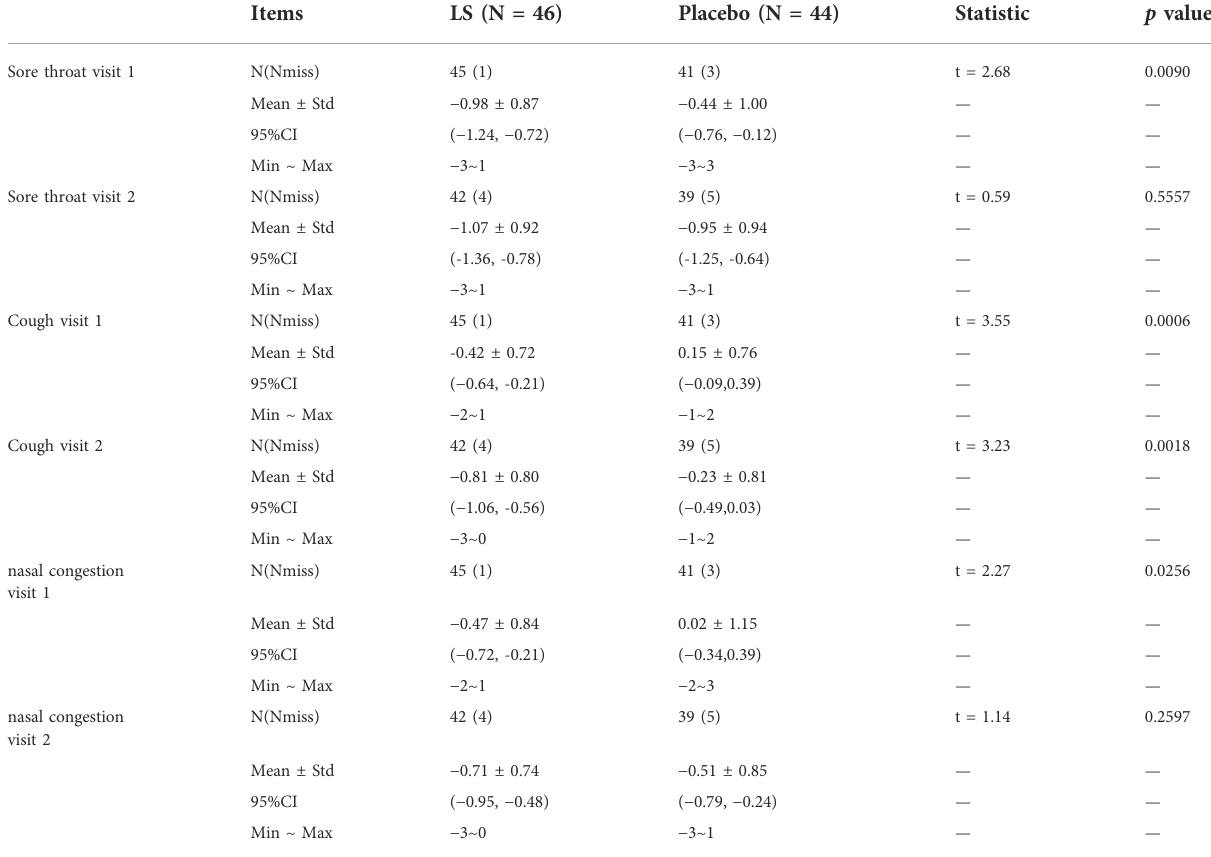
TABLE 4 Change values of sore throat, cough and nasal congestion symptoms from baseline between LS and Placebo groups (FAS).